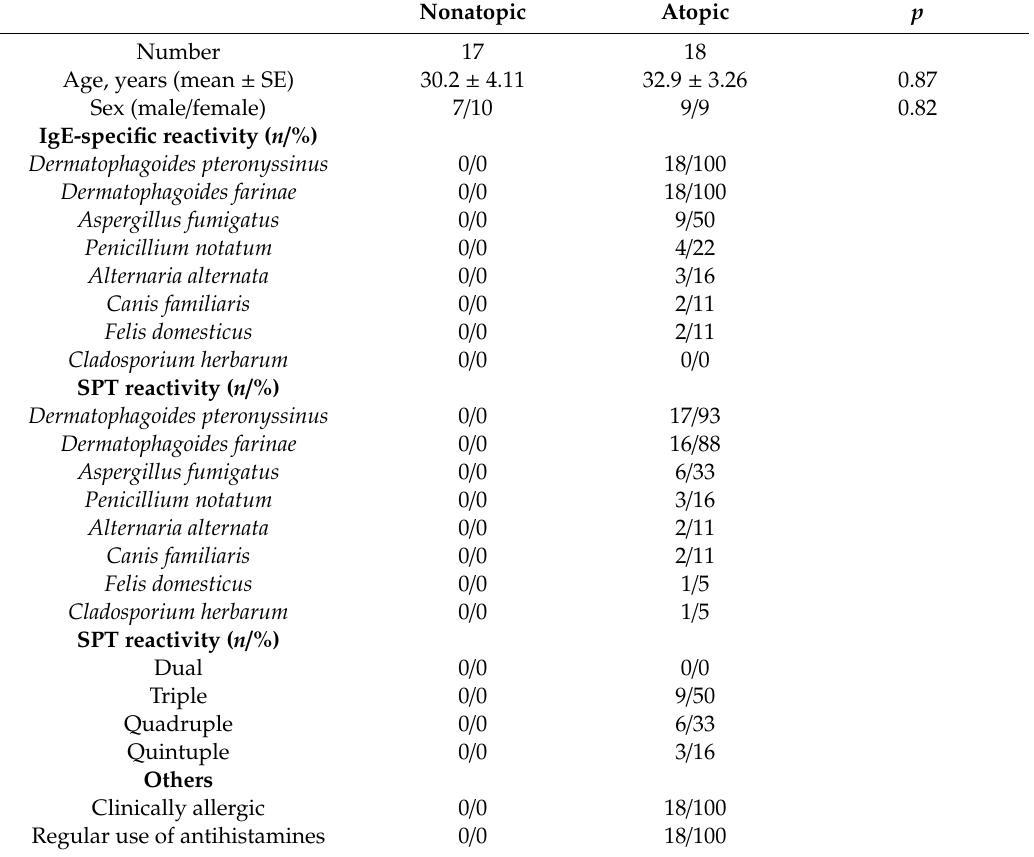
Table 1. Characteristics of the individuals included in the